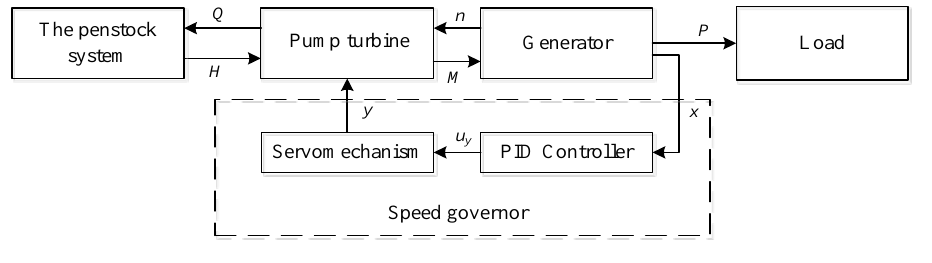
Figure 7. The schematic of the PTGS.